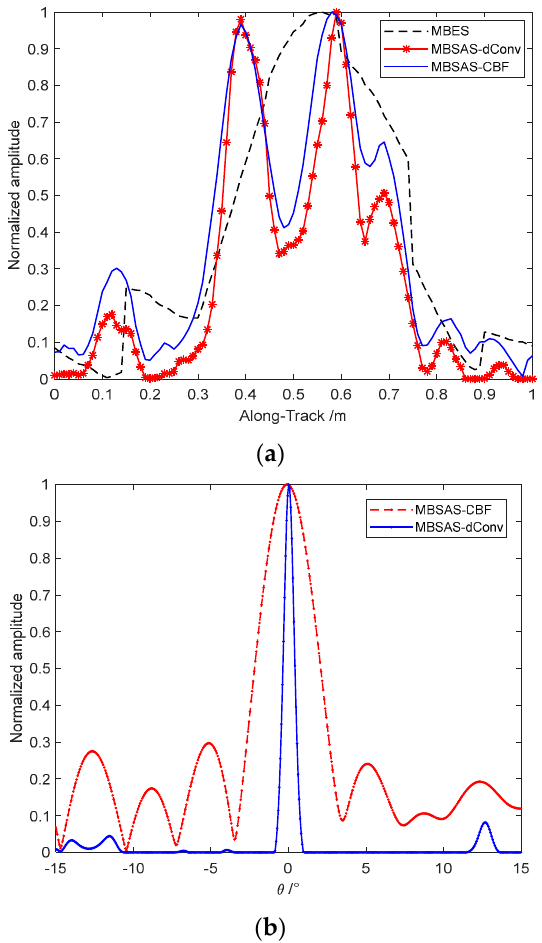
Figure 13. Sliced comparisons of different imaging methods: ( a ) sliced beamforming in the along-track direction of MBES, MBSAS with CBF, and MBSAS with deconvolved beamforming; and ( b ) sliced beamforming in the across-track direction through CBF and deconvolved beamforming of